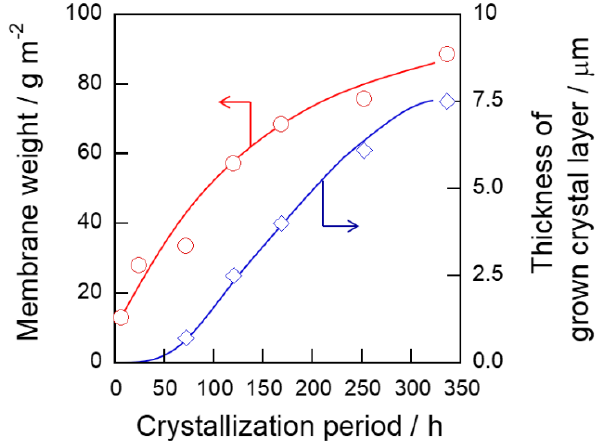
Figure 5. Membrane weight and thickness as a function of the crystallization period. O, membrane weight; ◇, the thickness of the grown crystal layer.